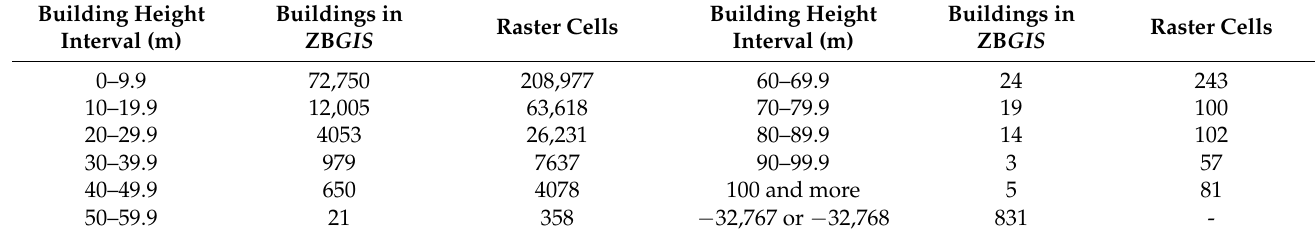
Table 2. Number of buildings/features (ZB GIS ) and raster cells with non-zero cell value (BH2012) in the study area.